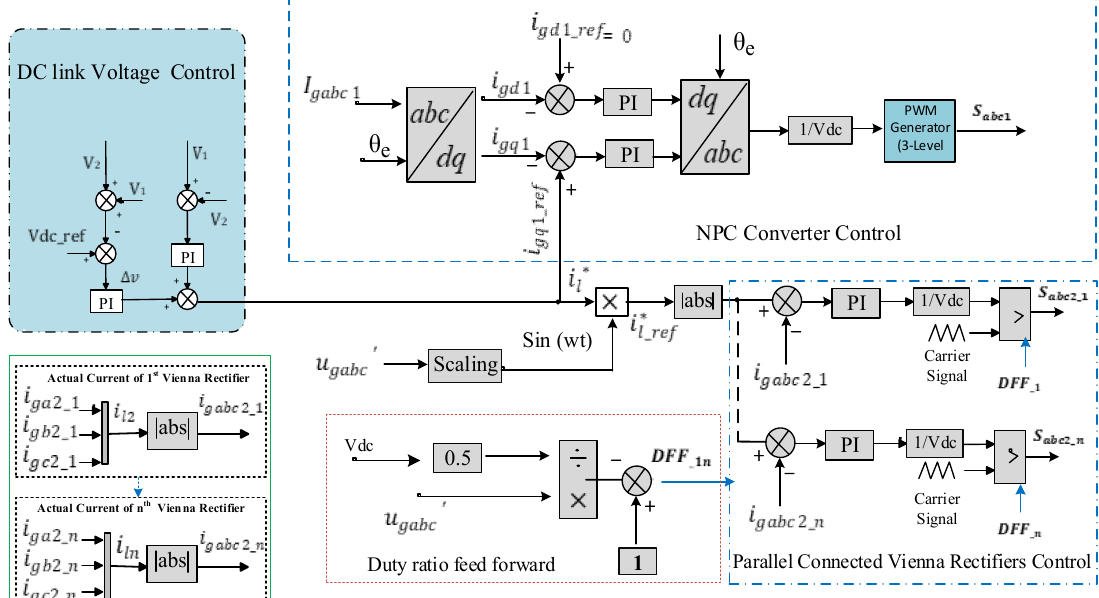
Figure 4. Control strategy of a proposed hybrid